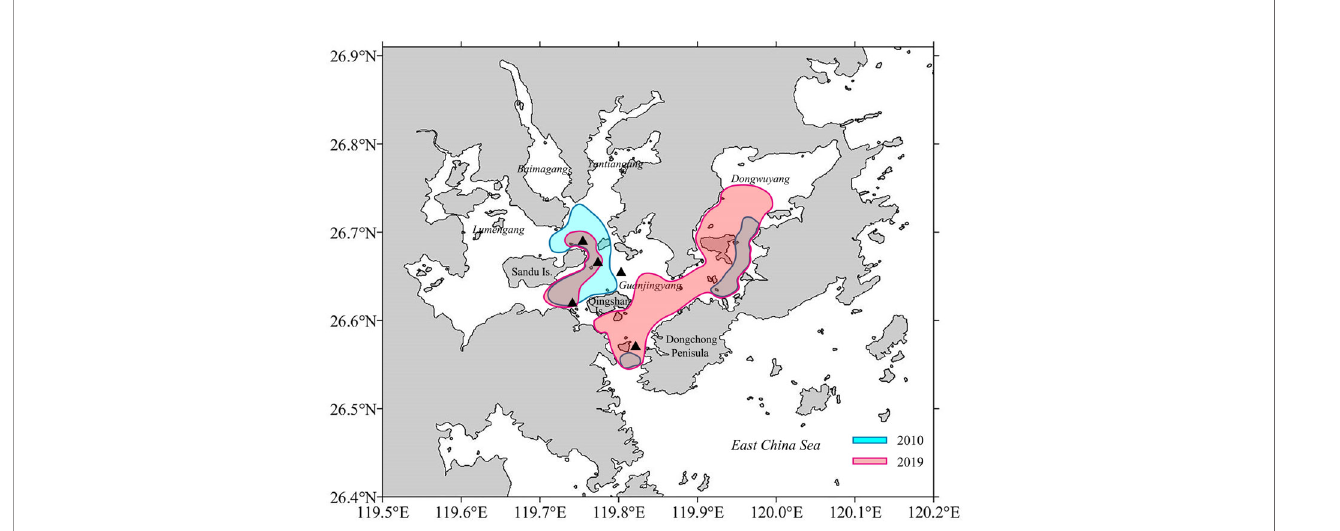
FIGURE 10 | Possible spawning areas for Larimichthys crocea based on the egg collection (Xu, 2018; Jiang et al., 2021). The black triangle symbols indicate the area where females with HO and/or POF occurred in this